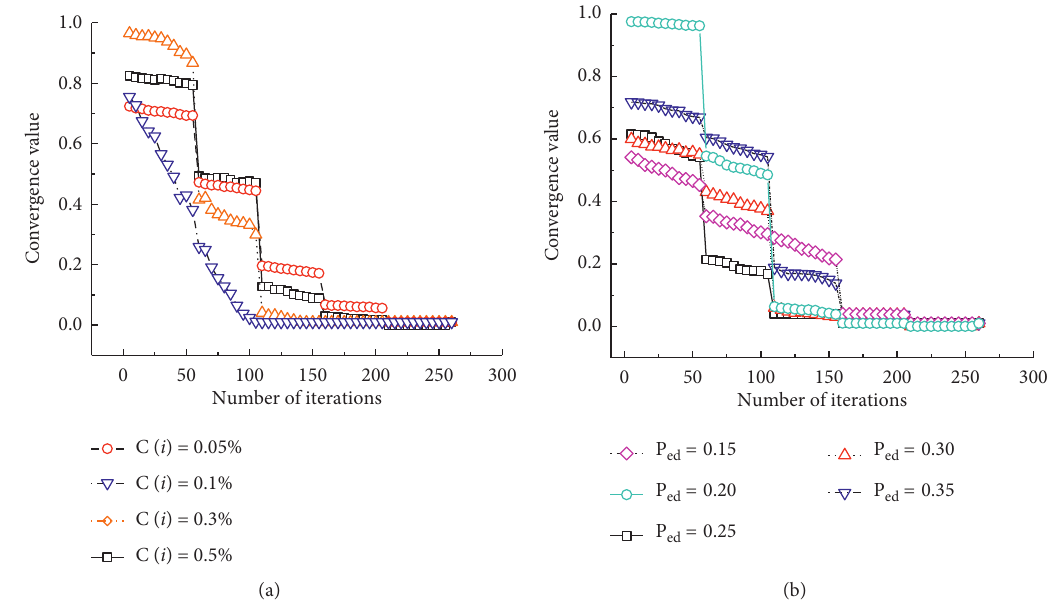
Figure 9: The influence law of BFOA parameters on convergence speed.